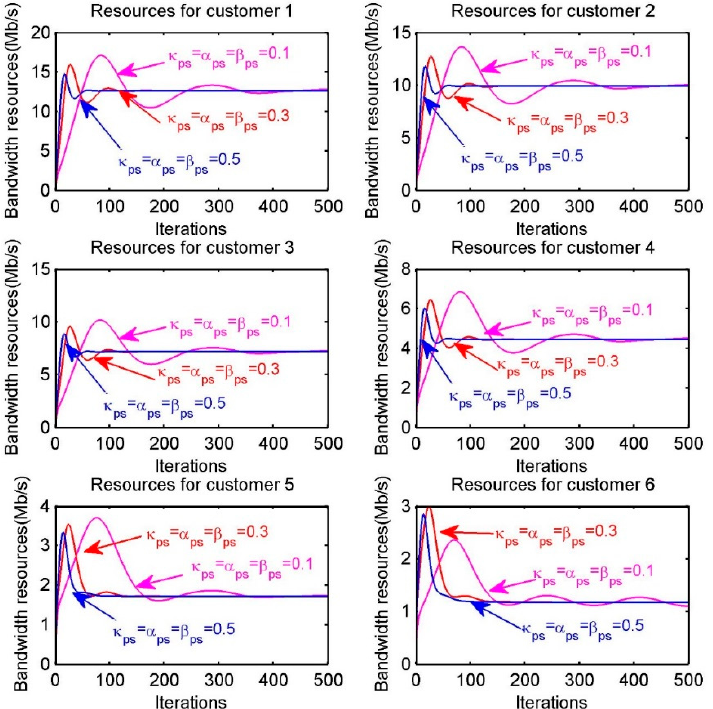
Figure 7. Resources allocation of each customer 𝑠 when choosing different step sizes.